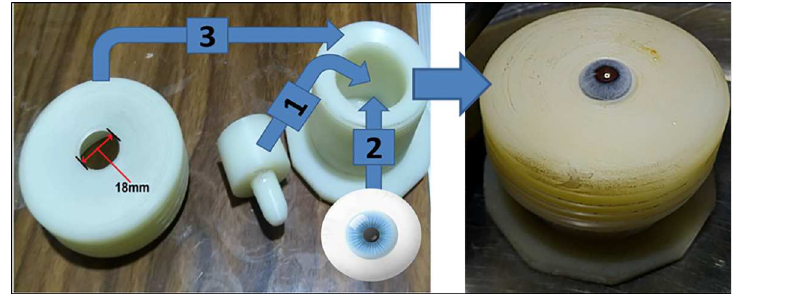
Fig 2. The designated globe